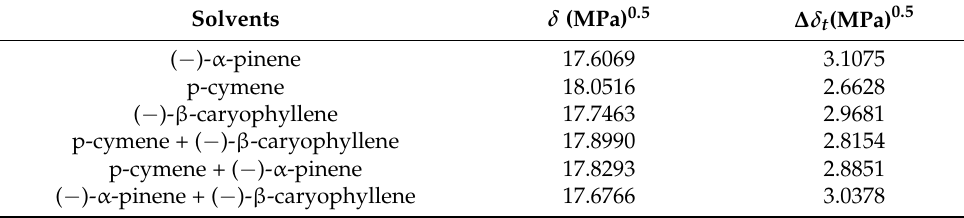
Table 2. Hansen solubility parameter (HSP) values for selected solvents a